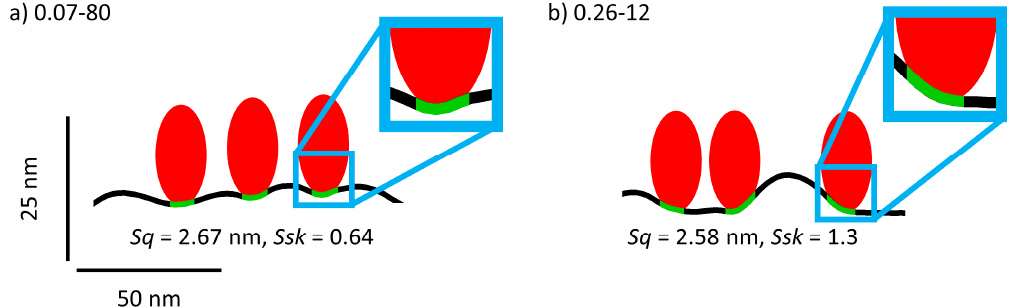
Figure 6. Schematic representation of TGL (red) adsorbed to the surfaces of samples 0.07-80 ( a ) and 0.26-12 ( b ), respectively. Both surfaces have rather similar Sq but different Ssk values as indicated in the figure. The height profiles were taken from corresponding AFM images. The size and shape of TGL were estimated based on its hydrodynamic radius of 8.6 nm. The areas of contact between TGL and the surface profile are highlighted in green. Note that the vertical axis has been enhanced by a factor of two to better visualize the comparably small differences between the two surface morphologies.